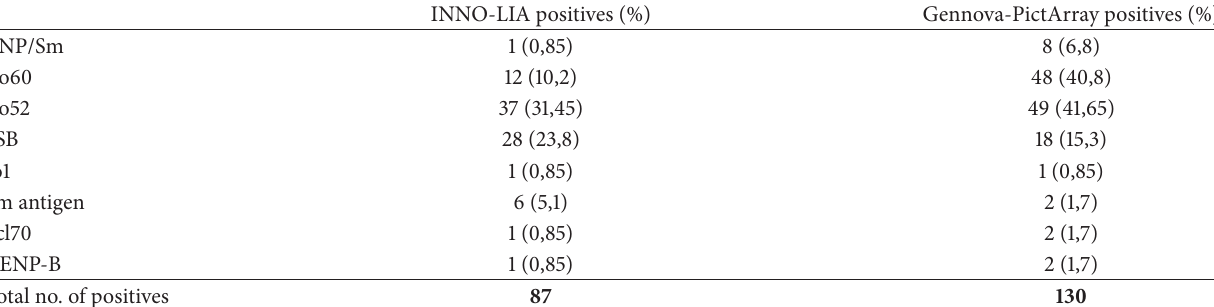
Table 2: The frequency (%) of positive autoantibodies using immunological assays in the connective tissue disease group ( 𝑛 = 85 ). INNO-LIA positives (%)